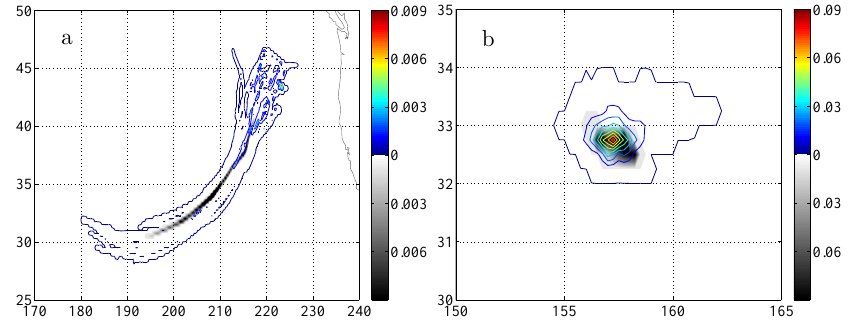
Fig. 6. Colored contours and gray contours indicate the ensemble mean and deterministic “concentration”, respectively, in a 0 . 25 ◦ × 0 . 25 ◦ (a) air column for r = 1µm and (b) cell for r = 10µm “deposited” particles after 2.5 days. Axis labeling corresponds to geographical coordinates in degree.